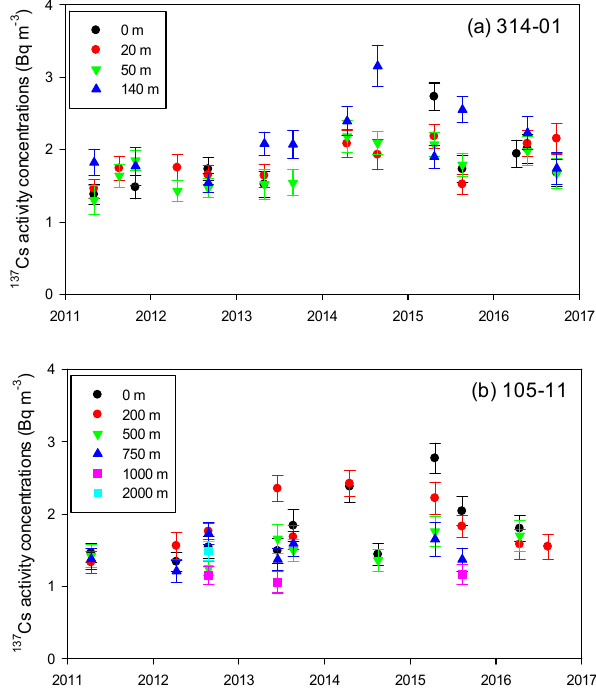
Figure 5. Temporal variations in the 137 Cs activity concentrations at stations (a) 314-01 and (b)